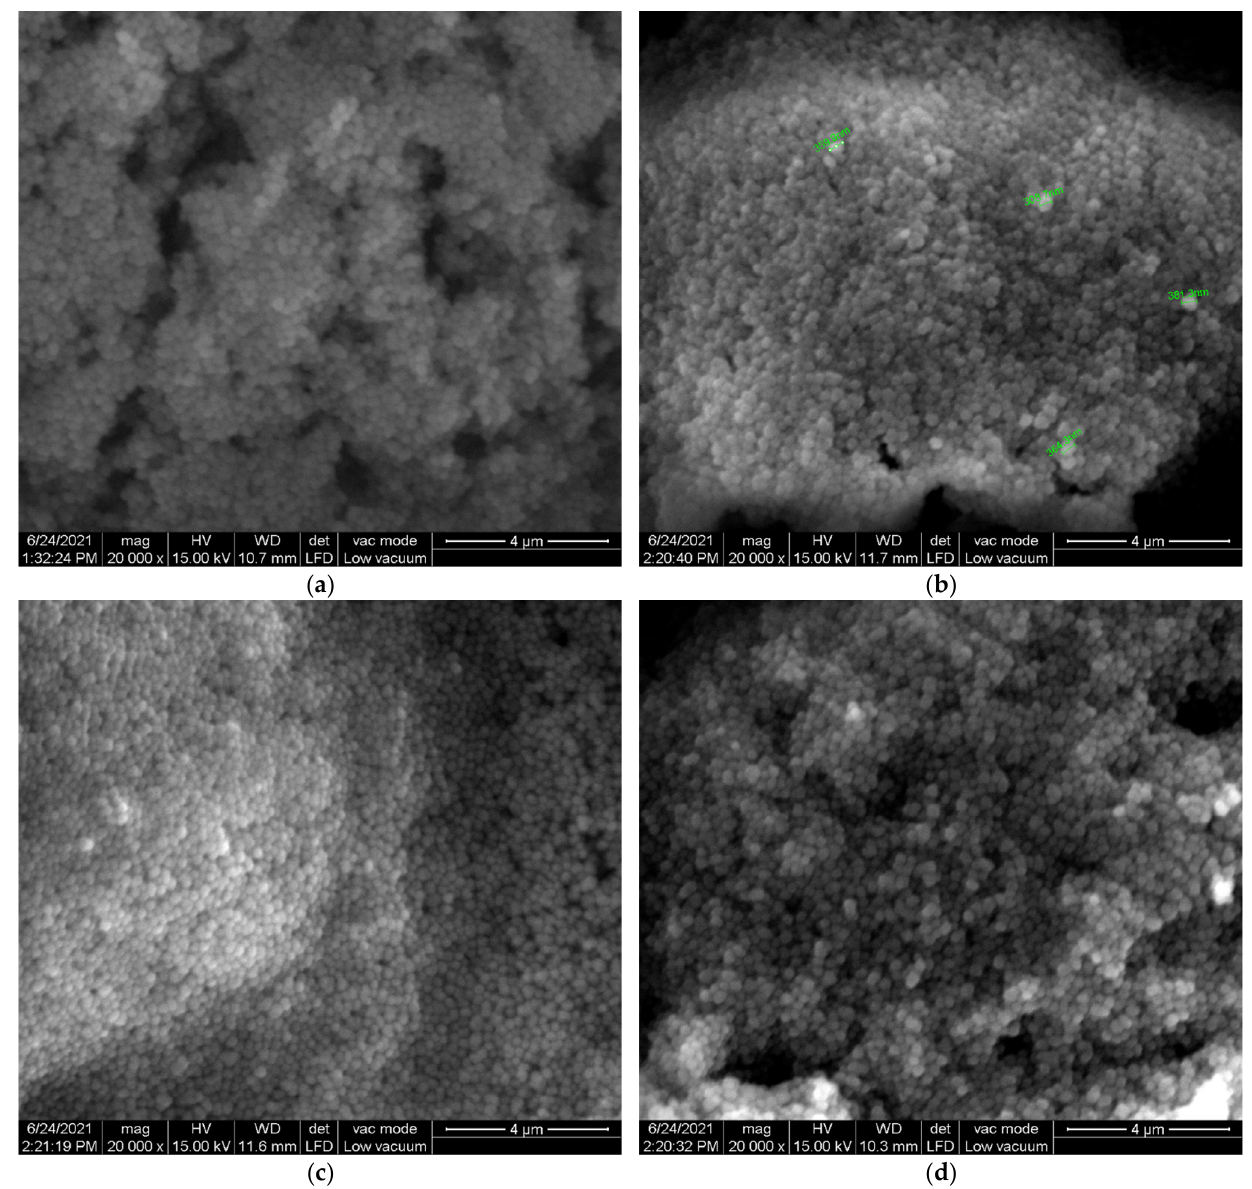
Figure 5. SEM image of silica and organically modified silica prepared at TEOS:NH 4 OH:H 2 O ratio of 1:12.7:57.3. SiO 2 -2 ( a ), SiO 2 -2-Org1 ( b ), SiO 2 -2-Org2 ( c ), and SiO 2 -2-Org3 ( d ).